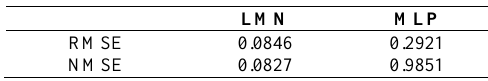
Figure 9. Lateral acceleration estimation error. Table 3. Results of lateral acceleration identification.